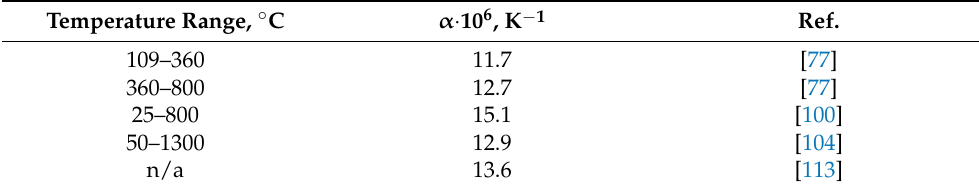
Table 4. Thermal expansion coefficients of Sr 2 MgMoO 6- δ in air. These data are also presented in Figure A1.